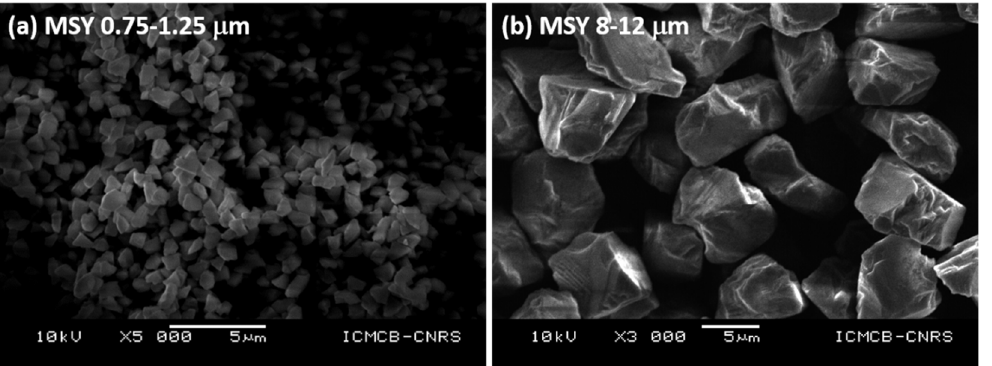
Figure 5. SEM images (SEI mode, 10 kV , WD = 10 mm ) of the starting powders: ( a ) 0.75–1.25 μ m grain size and ( b ) 8–12 μ m grain size.